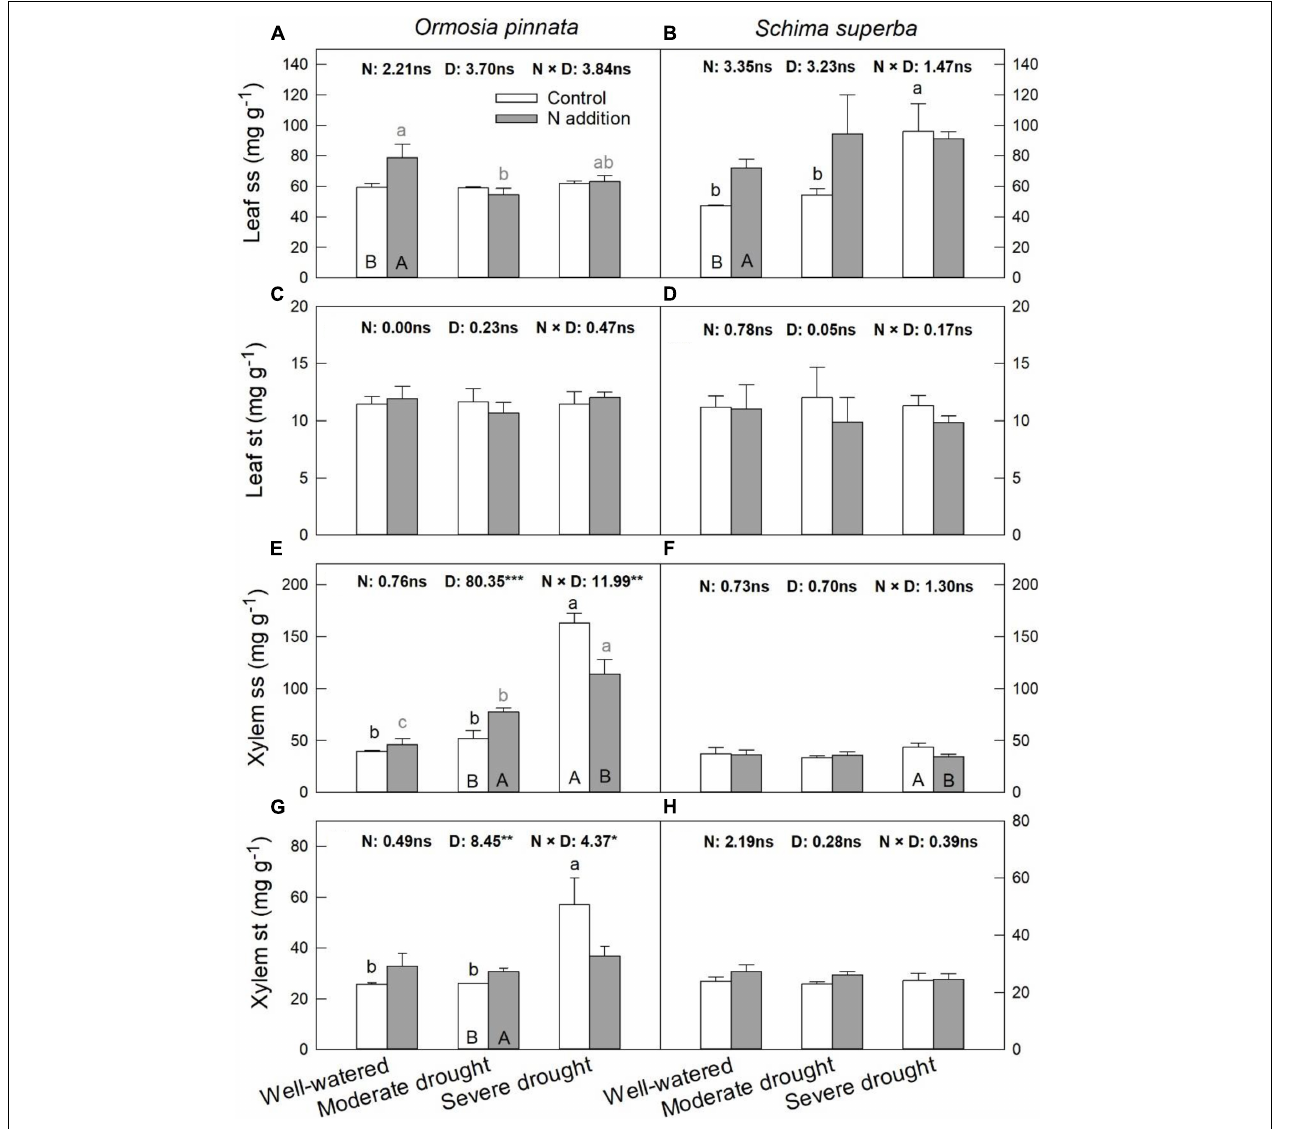
FIGURE 7 | Responses of leaf soluble sugar (ss; A,B ) and starch (st; C,D ), xylem ss (E,F) , and st (G,H) of O. pinnata and S. superba to different watering and N addition treatments. Bars show means ± SE ( n = 3). Different lowercase letters above bars indicate significant differences among three watering regimes within each N addition rate. Different capitalized letters below bars indicate significant differences between control and N addition within each watering regime. F -values of the two-way ANOVA of nitrogen (N), drought (D), and their interactions (N × D) are indicated. * P < 0.05; ** P < 0.01; *** P < 0.001; ns, not